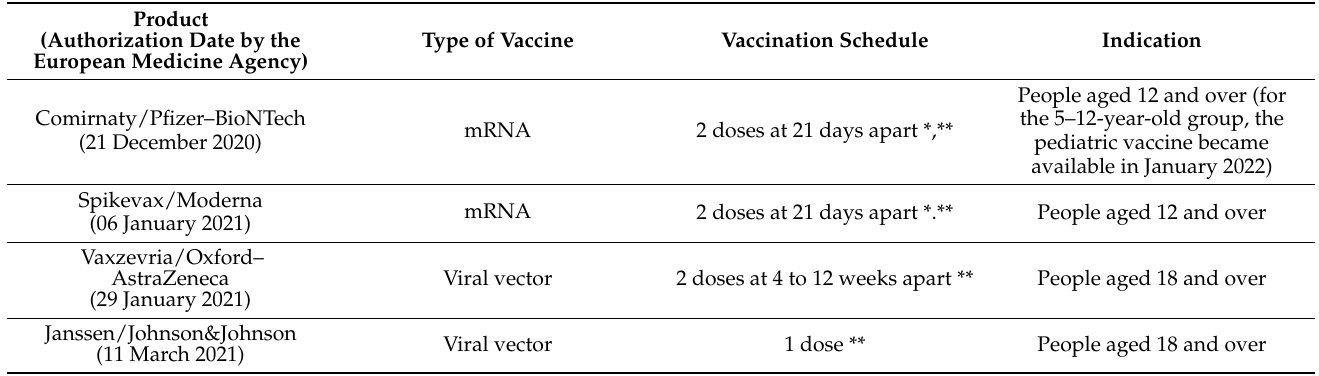
Table 1. Vaccines used in Romania, 27 December 2020–31 December